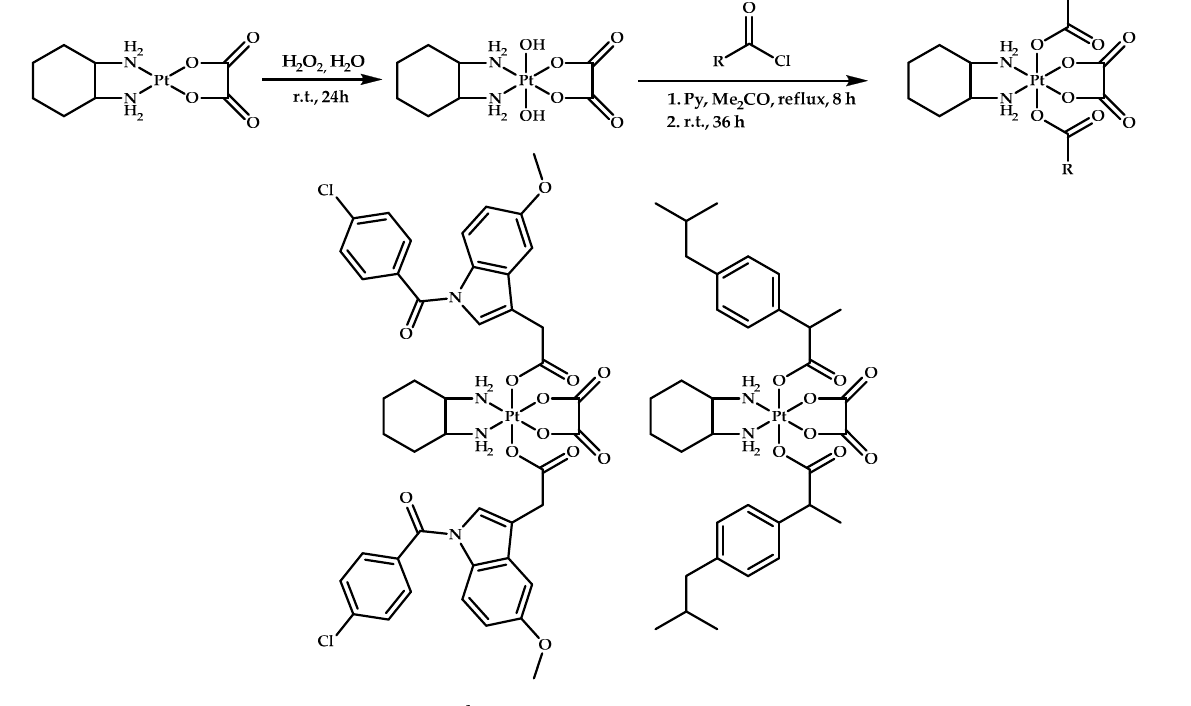
Figure 4. Synthesis of oxaliplatin-based platinum(IV) prodrugs 4 and 5 with indomethacin and ibuprofen as axial ligands.